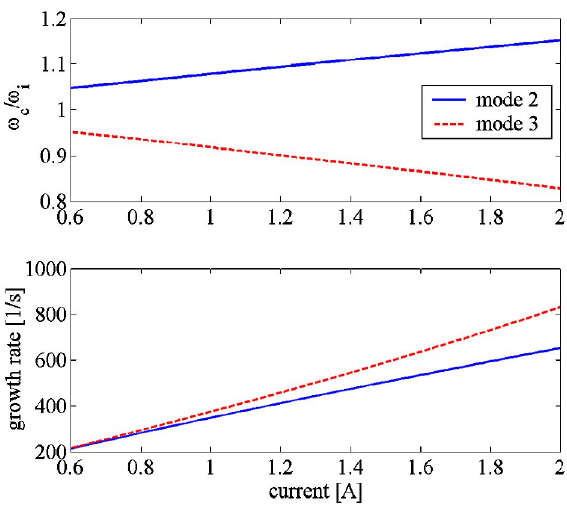
.FIG. 13. (Color) DA(cid:3)NE Touschek lifetime improvement with the harmonic